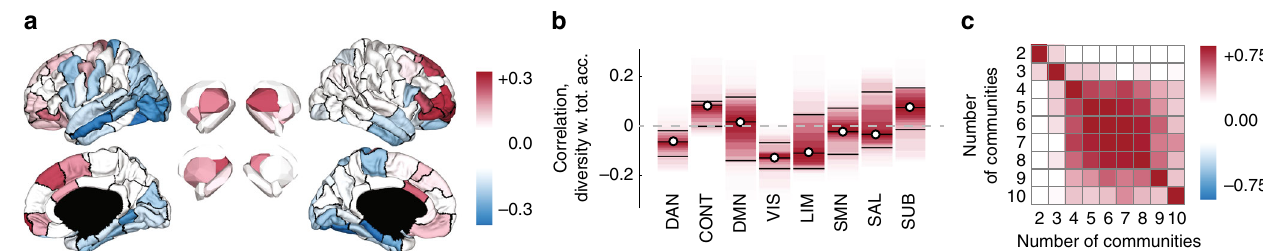
Fig. 8 Diversity index correlates with individual differences in performance on tasks demanding cognitive control. a Regional correlation coef fi cients of total accuracy with diversity index on the brain surface (shown with K = 5). Areas in white did not show a signi fi cant correlation after FDR correction for multiple comparisons. b Regional correlation coef fi cients grouped according to functional system: DAN, dorsal attention; CONT, cognitive control; DMN, default mode; VIS, visual; LIM, limbic; SMN, somatomotor; SAL, salience, and SUB, subcortical. c Similarity of regional correlation coef fi cients as a function of the number of communities, indicating robustness to the choice of K when 4 ≤ K